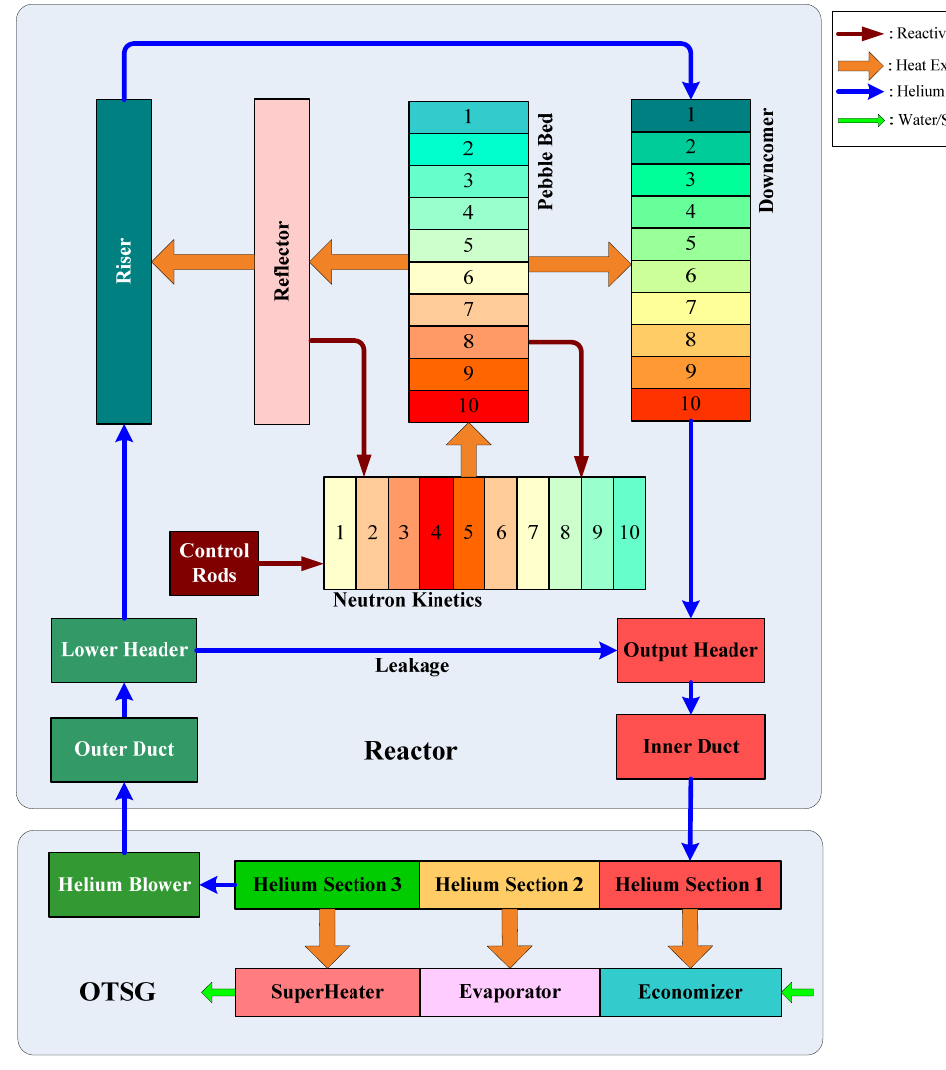
Figure 3. Schematic view of NSSS dynamics.